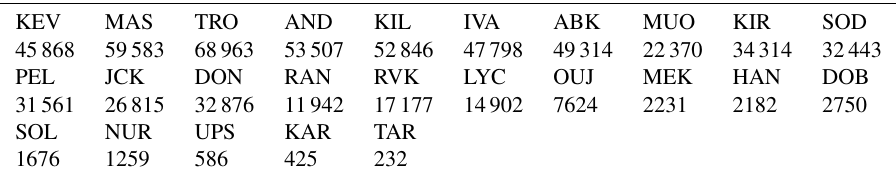
Table 2. Number of 10s data points in 2017 fitting the criterion | d (cid:49) H / d t | > 1nTs − 1 at each station, ordered by latitude, shown on the map in Figs. 4 and 5.